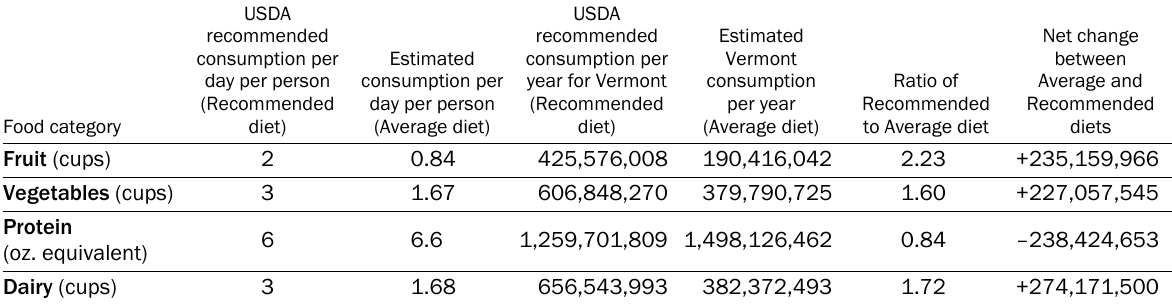
Table 1. Annual Consumption for Vermont: Average and Recommended